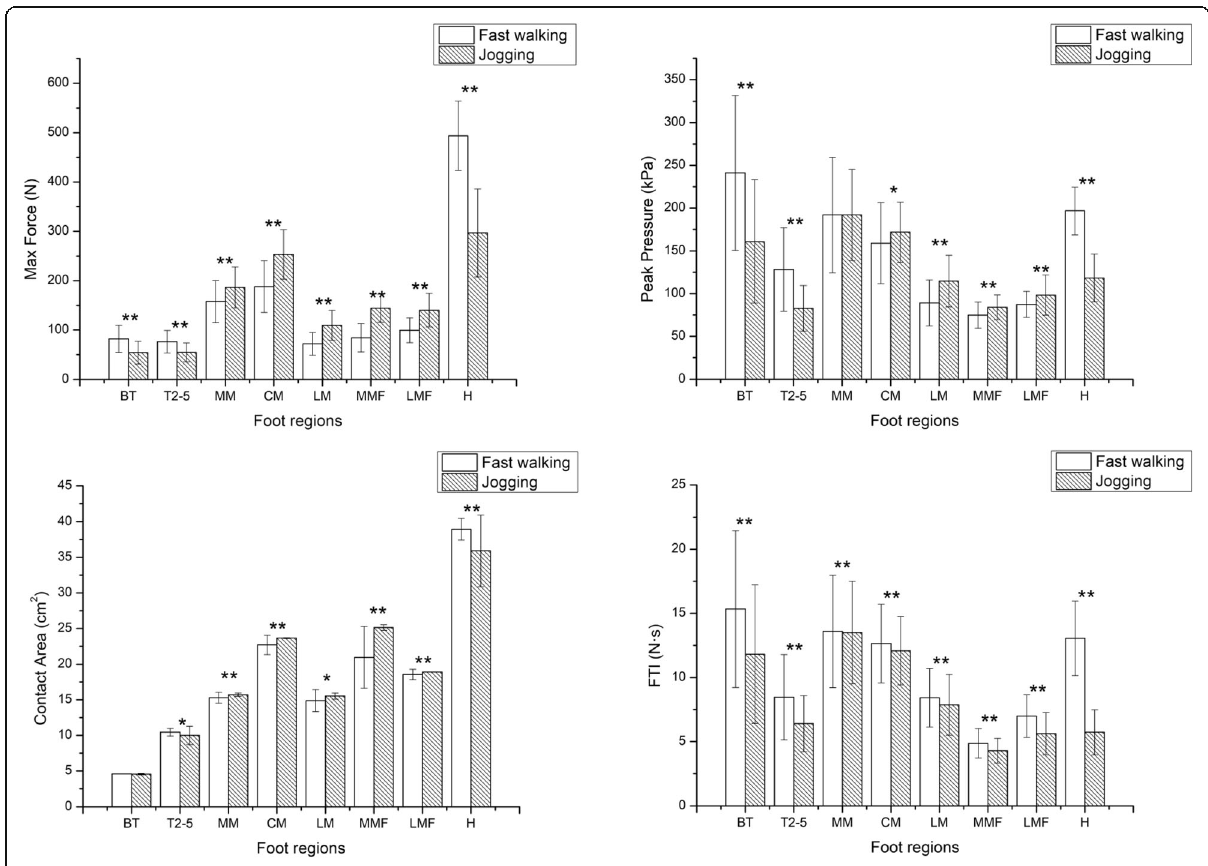
Fig. 2 Plantar pressure measurements (*, p < 0.05; **, p < 0.001)